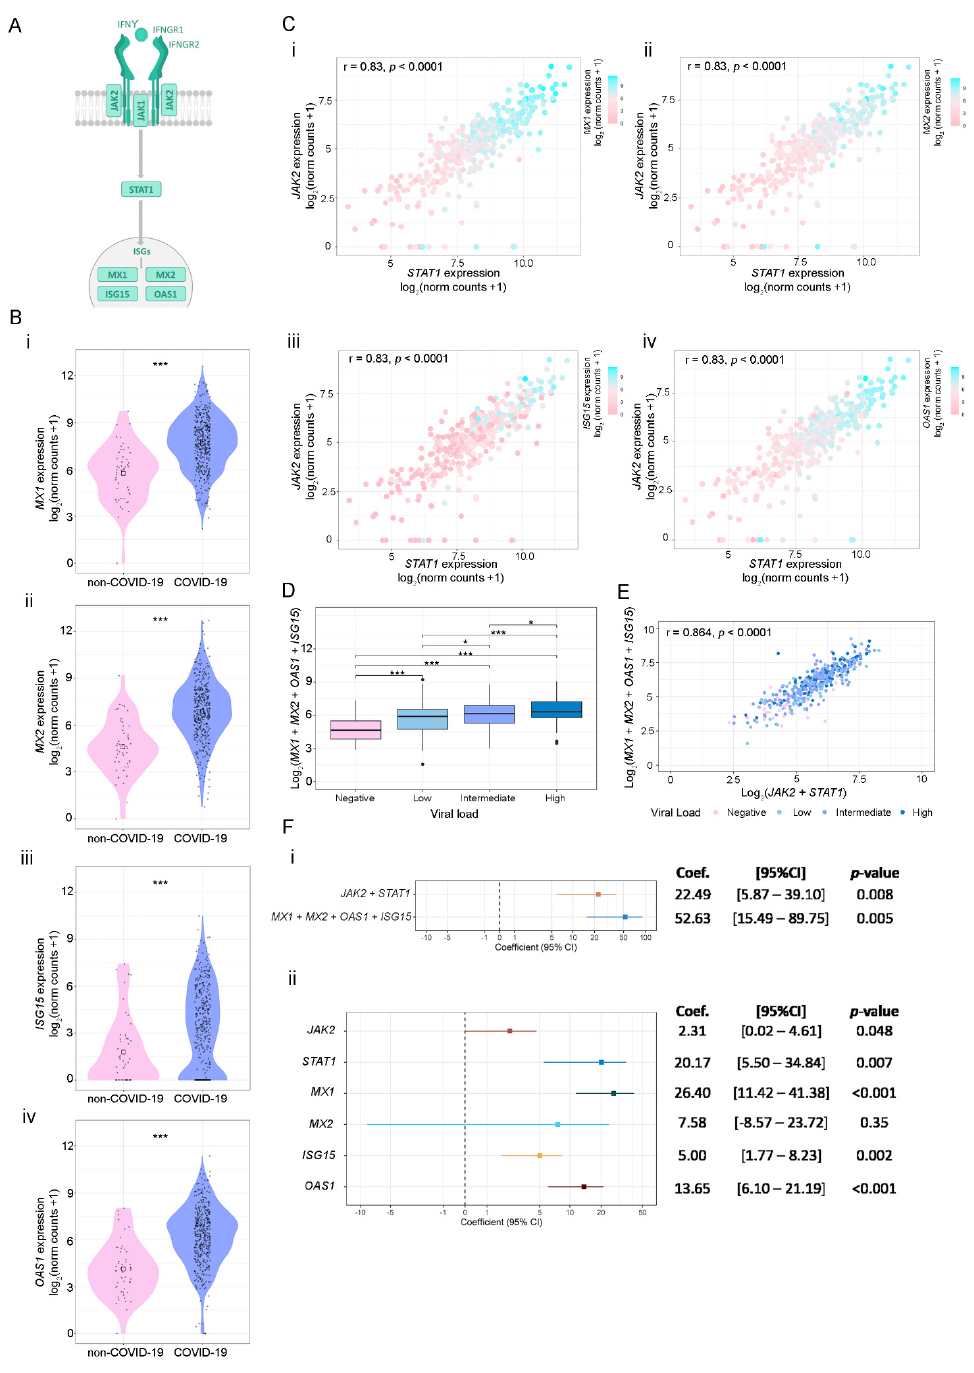
Figure 4. Association between STAT1 , JAK1 , and ISG’s expressions using the GSE152075 dataset. ( A ) Schematic representation of the canonical IFN- γ signaling pathway. ( B ) Gene expression